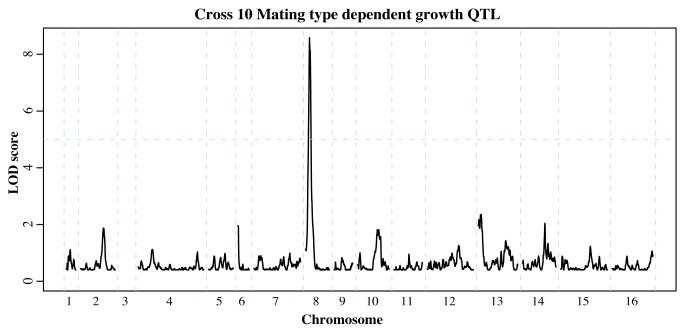
Mating type dependent QTL.Comparison of allele frequencies within MATa and MATα populations revealed loci that affect growth in a mating type dependent manner. The QTL on chromosome 8 encompasses GPA1, a negative regulator of the mating pathway that affects fitness in different strain backgrounds [50]. Chromosome 3 was omitted as it contains the mating type locus itself (see S8 Table for all mating type dependent QTL identified).